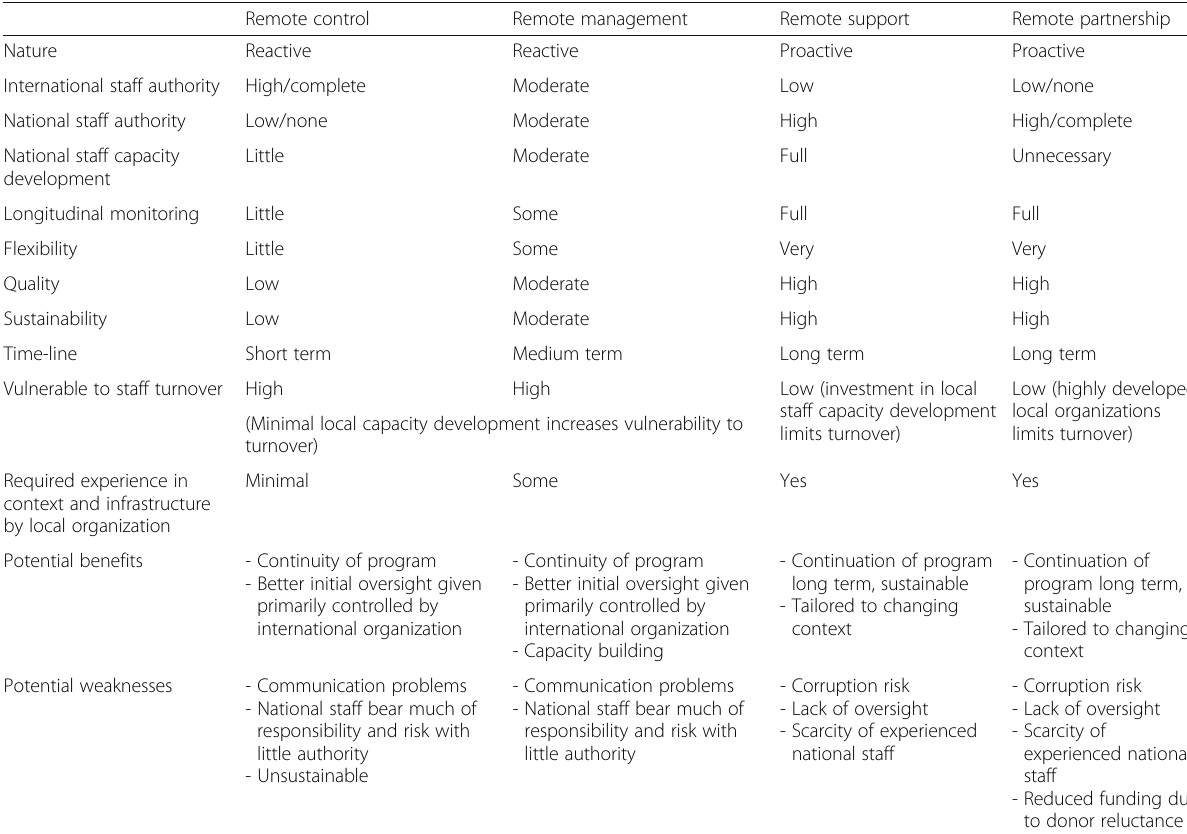
Table 3 Summary of remote operation modalities (Hansen 2008b; Oxfam International and Merlin 2009; Stoddard et al. 2006;